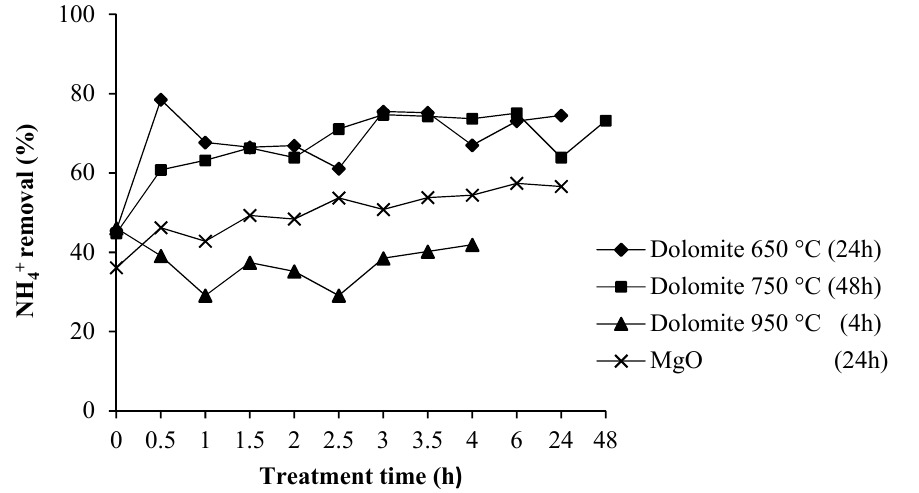
Figure 4 . Percentage of ammonium removals of MgO, dolomite 650°, dolomite 750 °C, and dolomite 950 °C (Mg:P:N molar ratios 1.3:1:2 for MgO and 1.3:2:2 for dolomites).